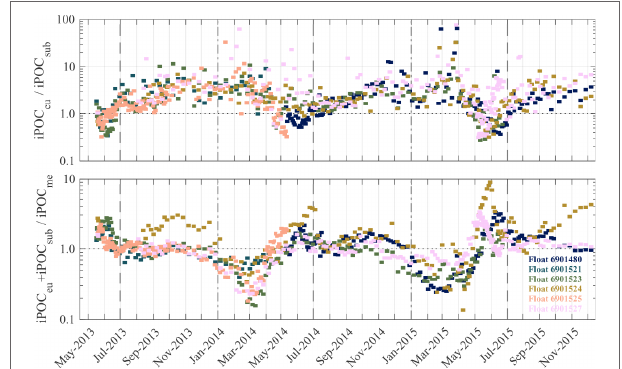
FIGURE 9 | Ratios of depth-integrated POC parameters described in Figure 8